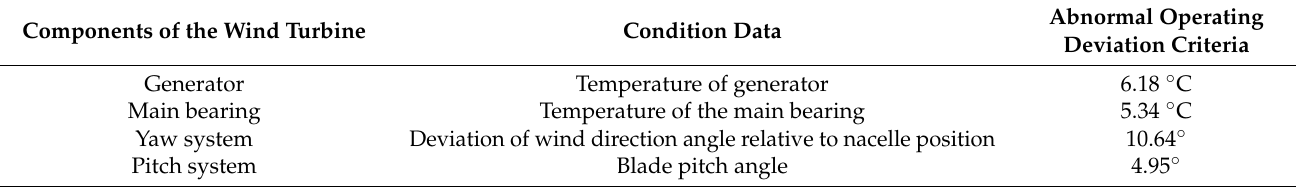
Table 6. Condition data for each part component and selected abnormal operating deviation